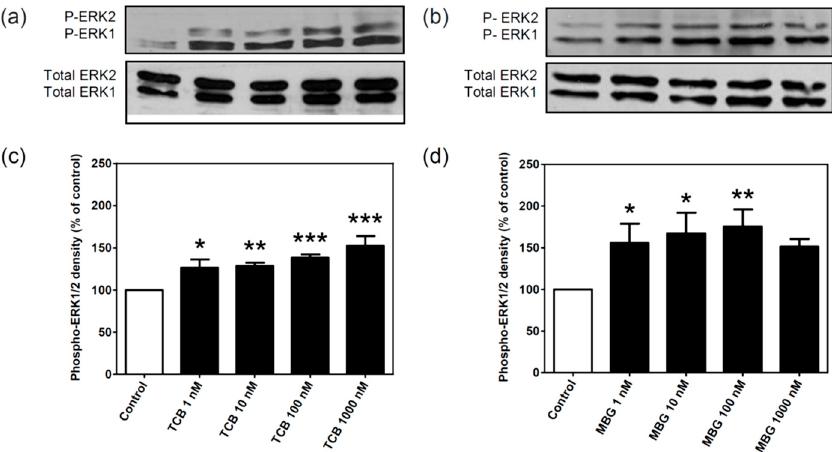
Figure 2. ERK1/2 activation by different concentrations of telocinobufagin (TCB) or marinobufagin (MBG). Serum-starved LLC-PK1 cells were treated with 1, 10, 100, and 1000 nM TCB or MBG for 15 min. Representative Western blots of phospho- and total ERK1/2 for TCB ( a ) and MBG ( b ) and relative optical density quantification in ( c ) and ( d ), respectively. Data are mean ± SEM of five independent experiments. * p < 0.05; ** p < 0.01; *** p < 0.005 vs. control.